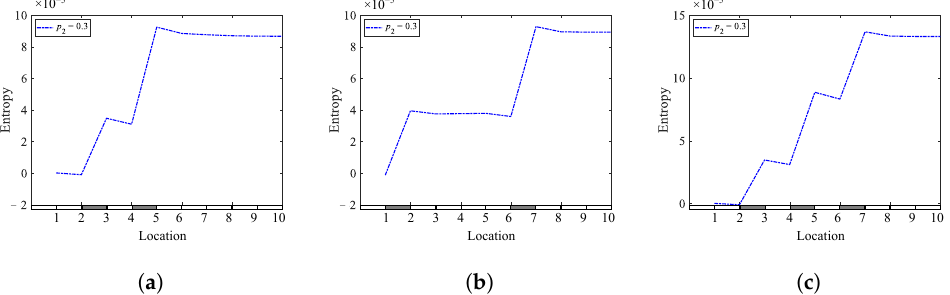
Figure 34. Entropy of a cantilever beam with multiple cracks for different crack depths and locations: ( a ) q = 0.25 and 0.45; ( b ) q = 0.15 and 0.65; ( c ) q = 0.25, 0.45, and